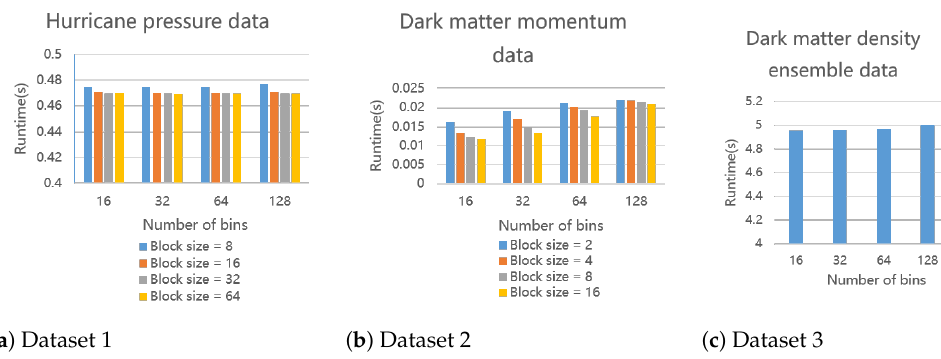
Figure 16. The execution time of our proposed parallel histogram modeling algorithm. We run it for three datasets on a 16-core CPU under given parameter settings. Dataset 3 is an ensemble data so there is no block size to